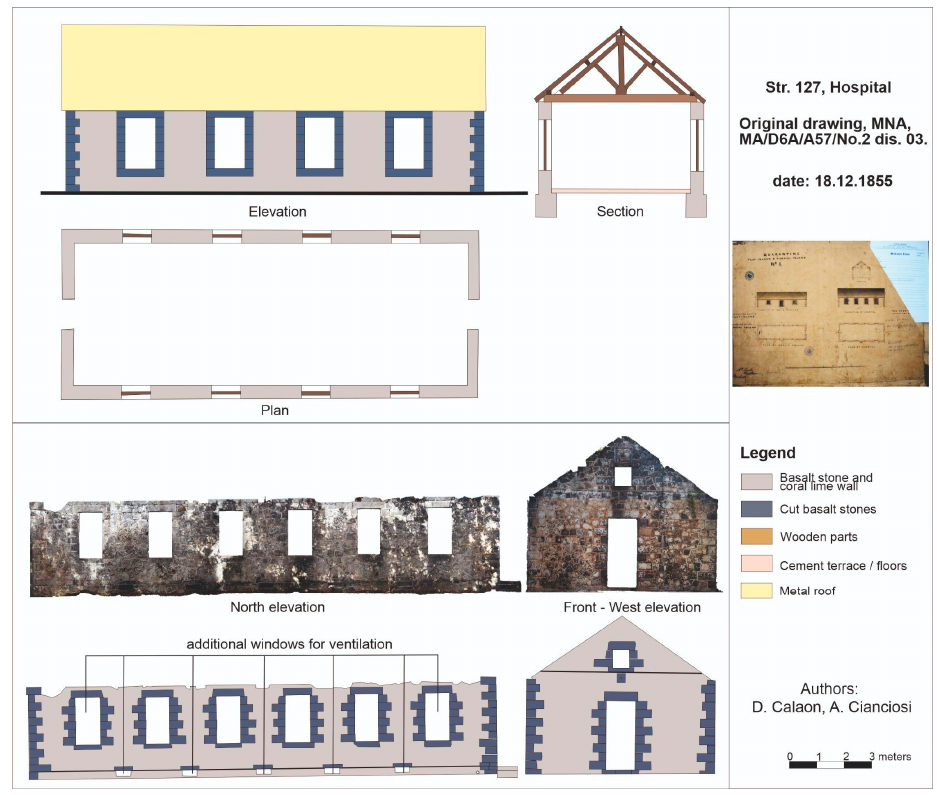
Figure 11. The hospital: redrawn plan from the archival document ( top ) in comparison with photo- grammetric orthomosaic image ( bottom ).